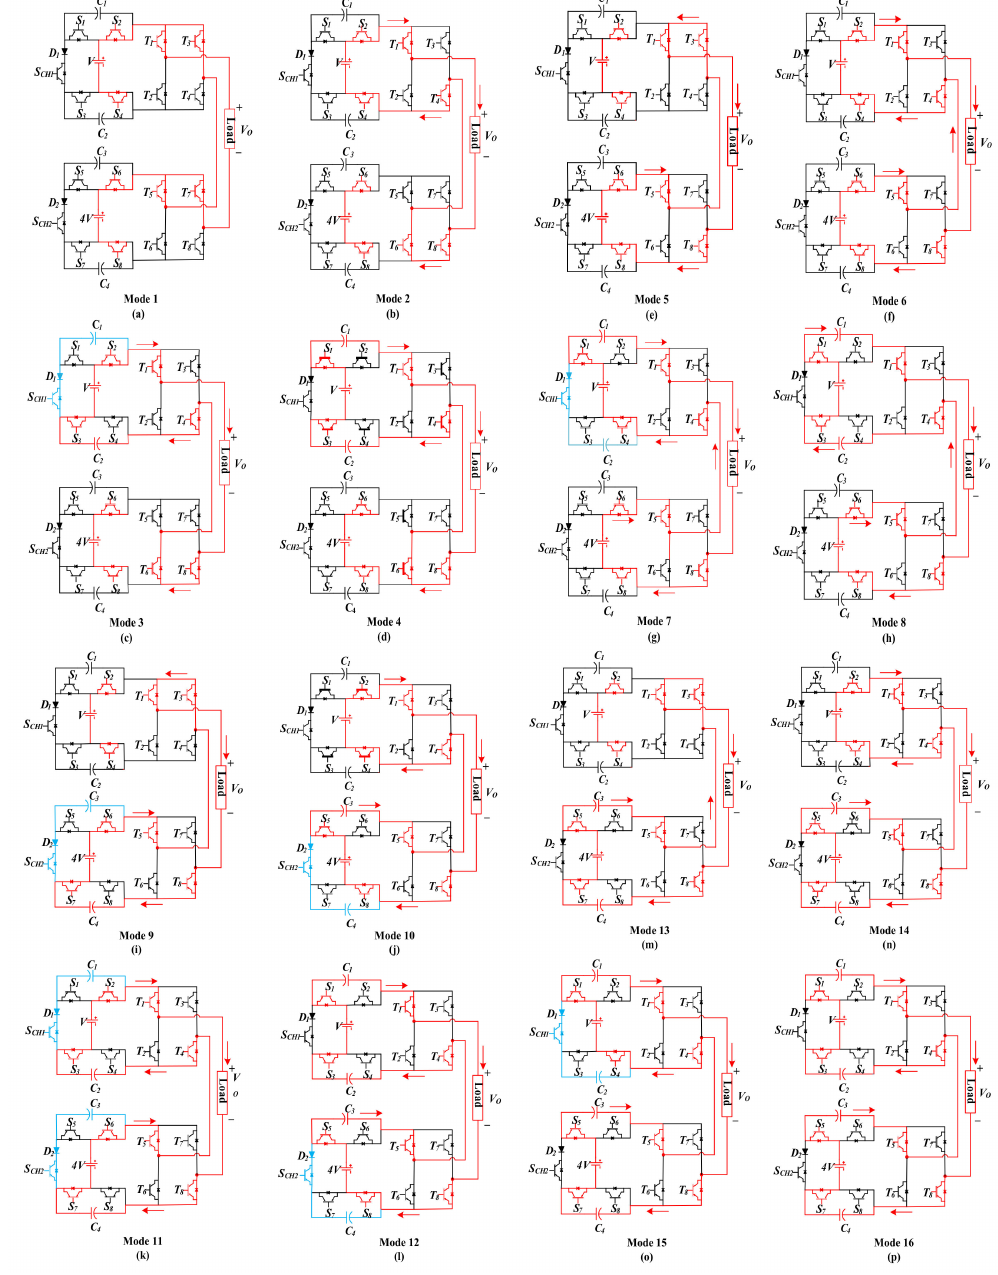
Figure 5. All positive mode of 31 level SCMLI. ( a ) Mode 1; ( b ) Mode 2; ( c ) Mode 3; ( d ) Mode 4; ( e ) Mode 5; ( f ) Mode 6; ( g ) Mode 7; ( h ) Mode 8; ( i ) Mode 9; ( j ) Mode 10; ( k ) Mode 11; ( l ) Mode 12; ( m ) Mode 13; ( n ) Mode 15; ( o ): Mode 15; ( p ): Mode